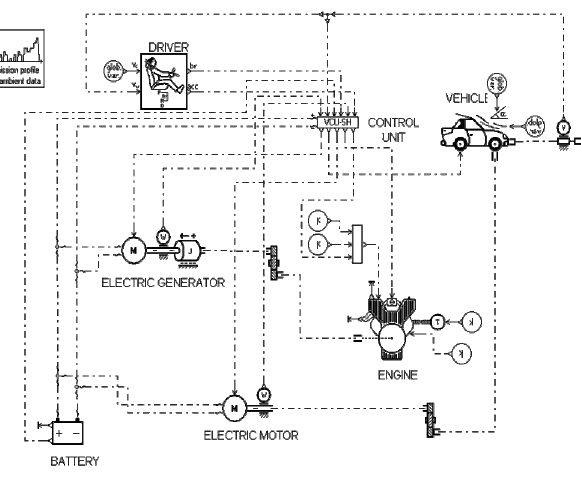
Fig 13. Simulation model of hybrid vehicle with series drive realized with AMESim